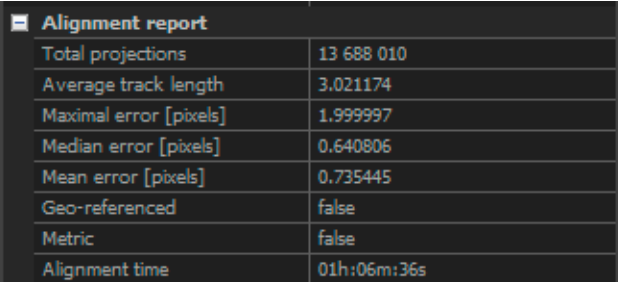
Figure A3. Alignment Report for Room 18 .